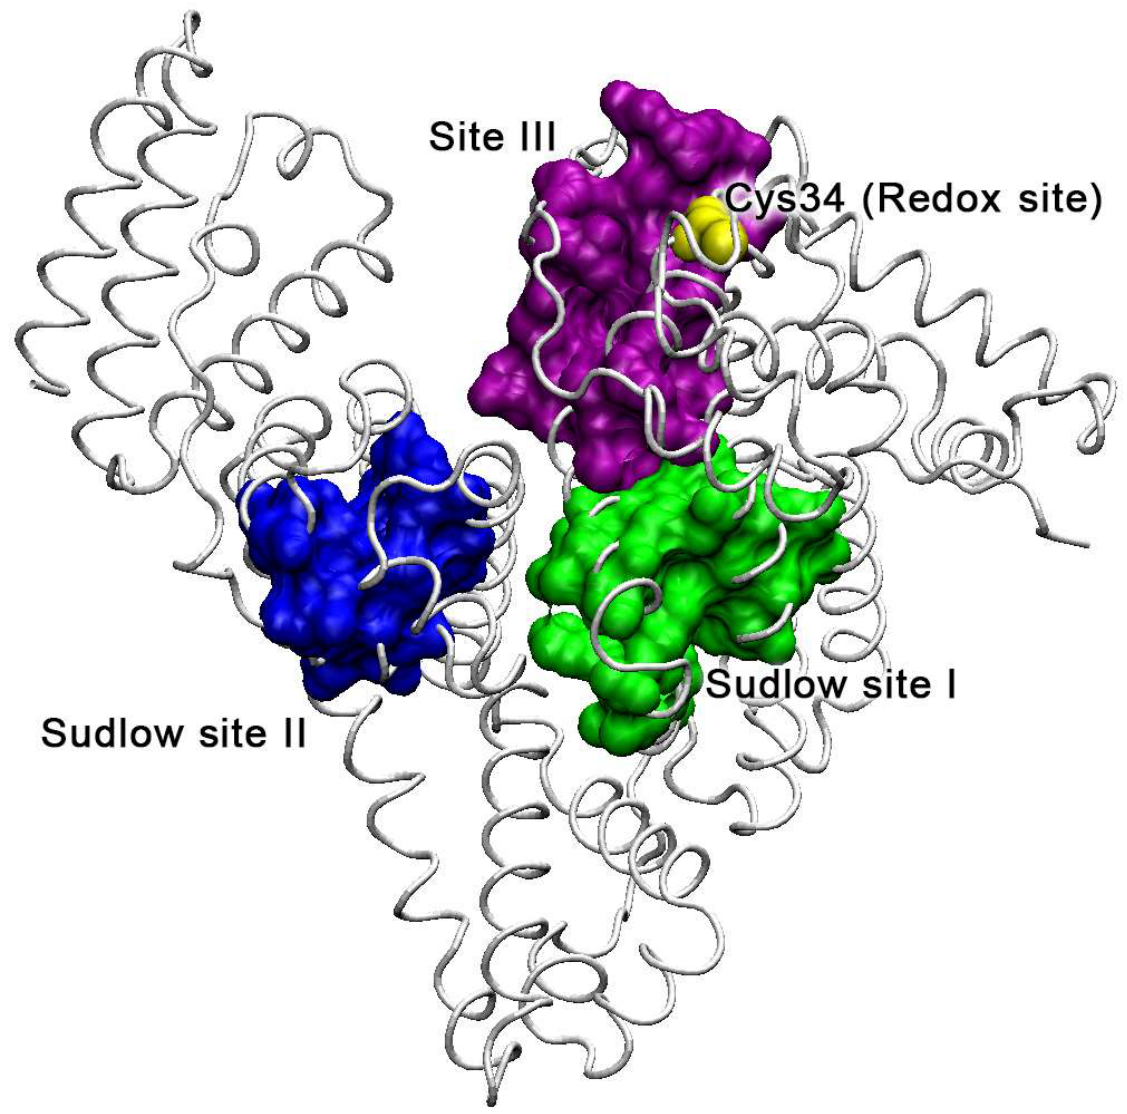
Figure 1. The main binding and redox sites of albumin on the example of bovine serum albumin (BSA). BSA backbone is shown in grey. Green, blue and purple surfaces show the areas of major albumin binding sites—Sudlow site I, Sudlow site II and Site III, respectively; Cys34 of the main redox site is represented in yellow. To create the figure, a three-dimensional structure of BSA from the Protein Data Bank (PDB) [1] (code 4jk4 [2]), and Visual Molecular Dynamics software (version 1.9.3, University of Illinois, Champaign, IL, USA) [3] were used.